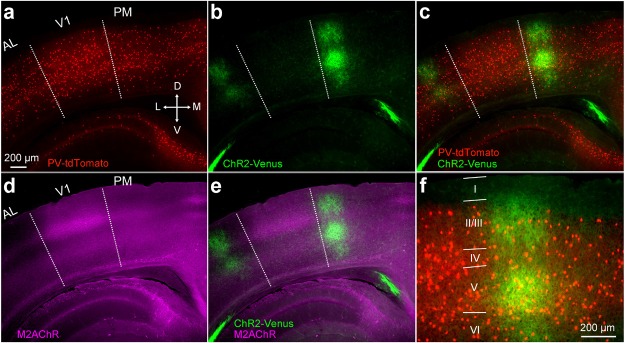
V1→PM pathway in a PV-tdT mouse.(a−e) Image of coronal section two weeks after the injection of AAV2/1.CAG.ChR2-Venus.WPRE.SV40 into V1. Slice includes areas PM, AL, and V1. PV cells in red (a,c), ChR2-Venus-expressing axons in green (b,c). Merged image in (c). Dotted lines demarcate AL/V1 and V1/PM boundaries indicated by the sharp decline of M2 expression between V1 and surrounding areas (d). V1 is characterized by a thick band of M2 expression (purple) in L4, showing that the axonal terminations (green) lie outside V1 (d,e). (f) Higher magnification view of PM from (c) with layers indicated.